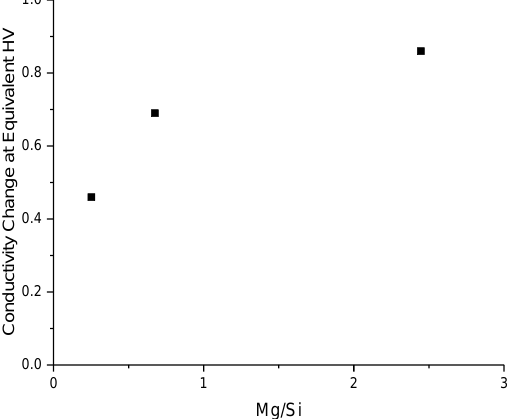
Figure 21. Conductivity difference between [DQ] − [WQ + 0.5 h NA] conditions at the point of nearly equivalent under-aged hardness, shown as a function of Mg/Si. Due to the different dependencies of precipitates and clusters on hardness and conductivity, the larger (positive) values indicates a larger proportion of clusters compared to precipitates. Equivalent values were selected by eye, so error bars are omitted.